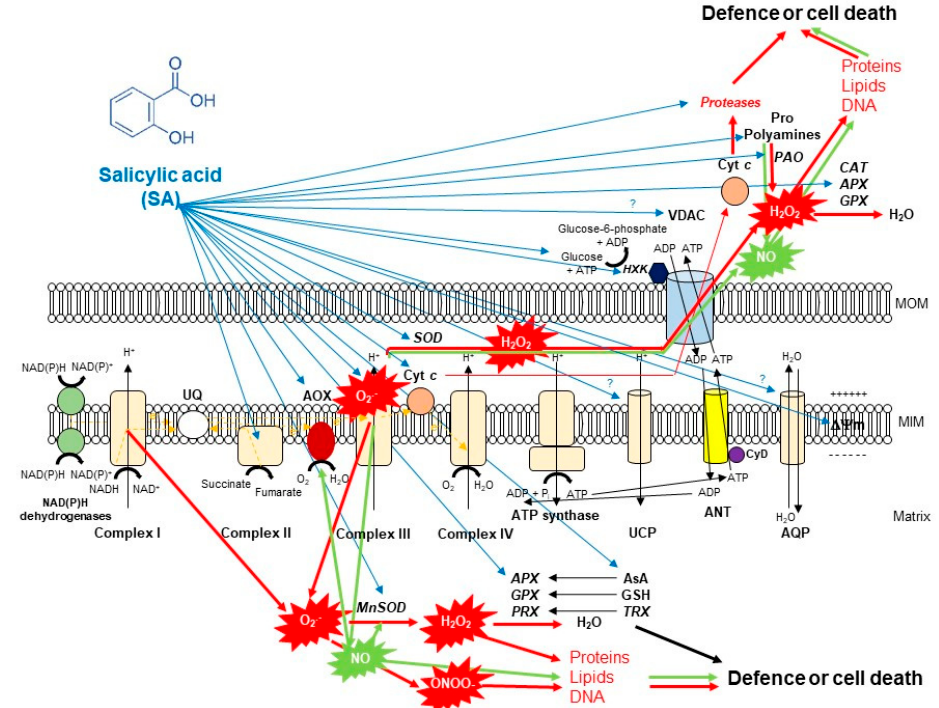
Figure 2. A schematic illustration of the effects of salicylic acid (SA) on the metabolism of reactive oxygen species (ROS) in plant mitochondria. The accumulation of endogenous SA leads to an increase in mitochondrial ROS and nitric oxide (NO) production. Mitochondrial complex III plays the dominant